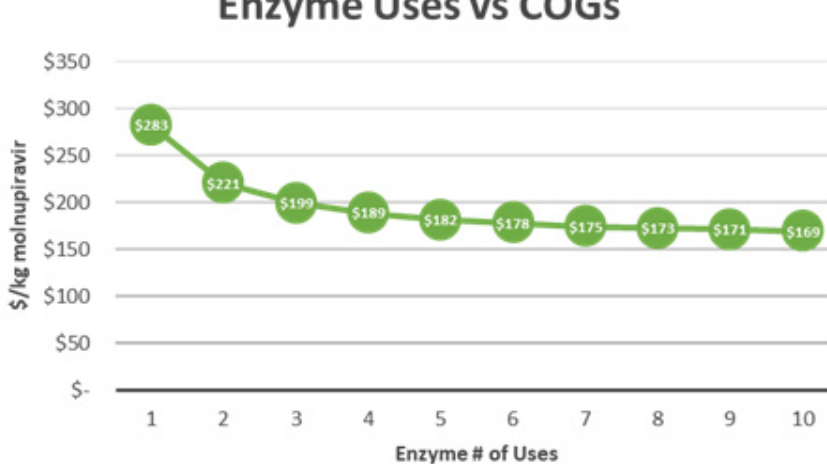
Figure 11. Biocatalytic Route (Manchester) – Enzyme Use versus COGs.